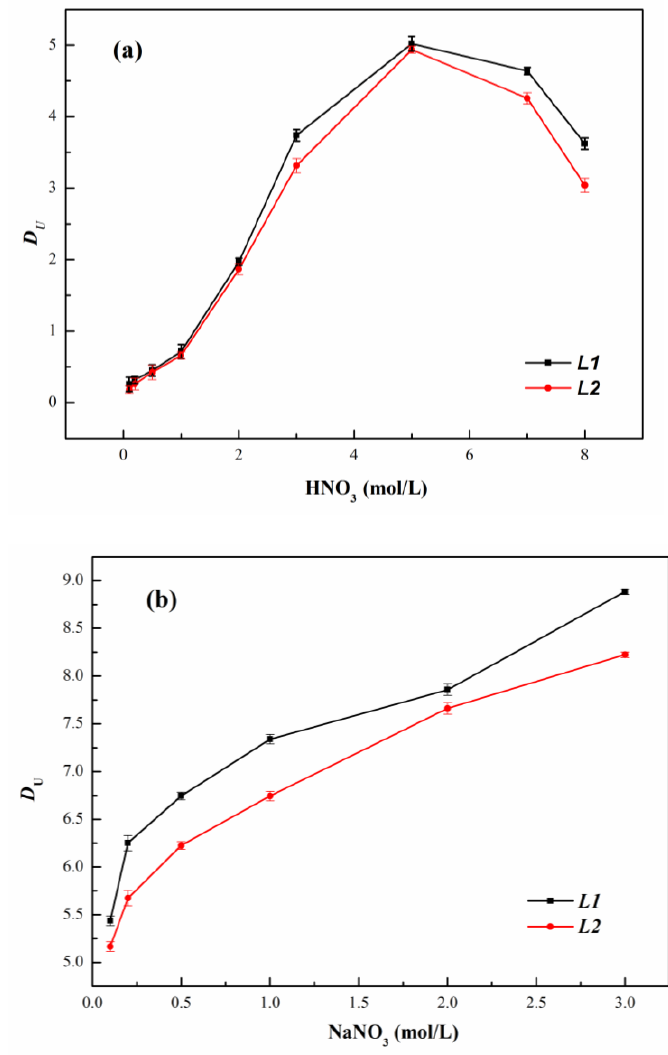
Figure 3. D U by L in n-dodecane as a function of ( a ) the nitric acid concentration ([U(VI)] ini = 10 g/L) ( b ) the NaNO 3 concentration ([HNO 3 ] ini = 5 mol/L, [U(VI)] ini = 10 ( b ) the NaNO 3 concentration ([HNO 3 ] ini = 5 mol/L, [U(VI)] ini = 10 g/L).